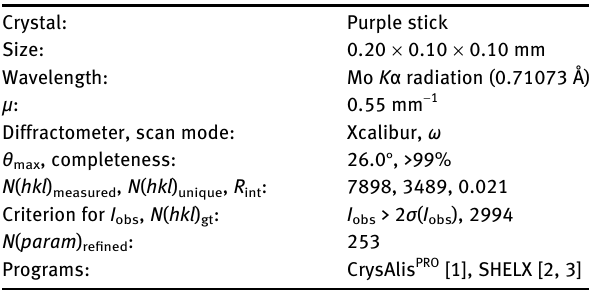
Table 1 contains crystallographic data and Table 2 contains the list of the atoms including atomic coordinates and displacement parameters.